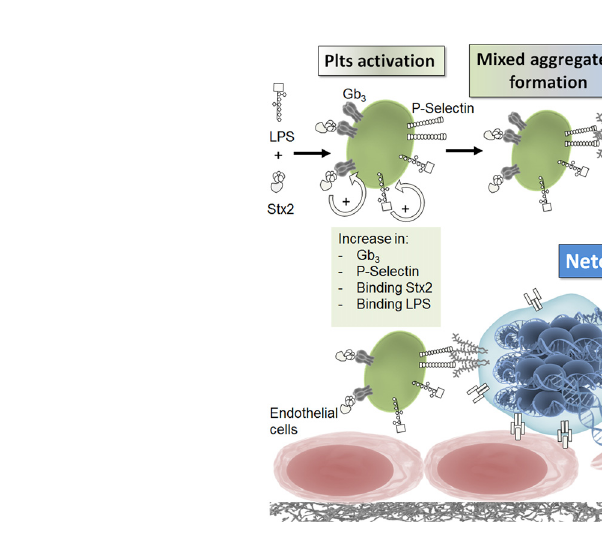
FIGURE 7 | Schematic model. This model summarizes the results obtained in this work. See discussion for